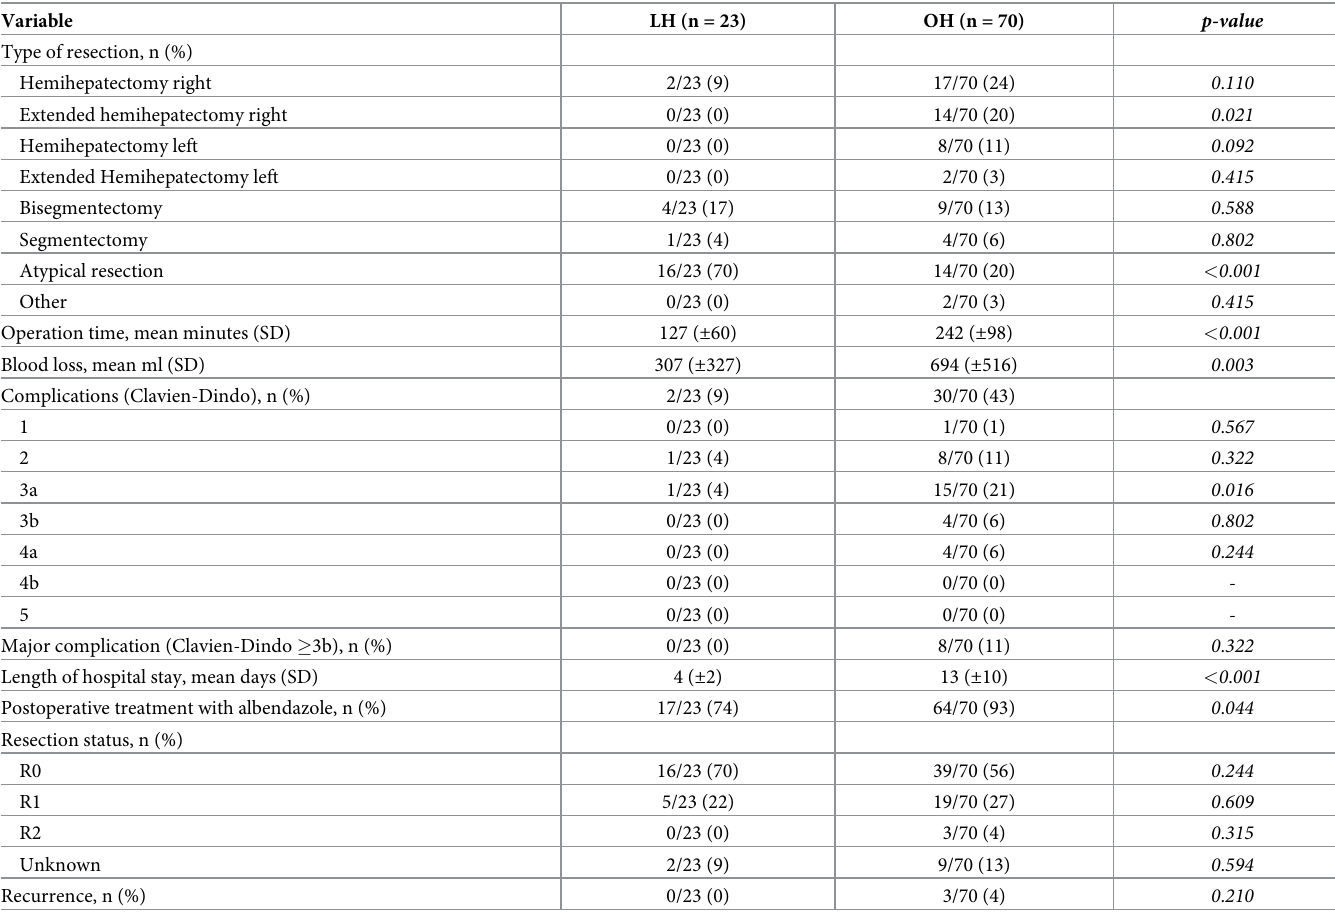
Table 2. Comparison of perioperative data between laparoscopic and open resection of patients with hepatic alveolar echinococcosis. Variable LH (n = 23) OH (n = 70) p-value Type of resection, n (%) Hemihepatectomy right 2/23 (9) 17/70 (24) 0 .